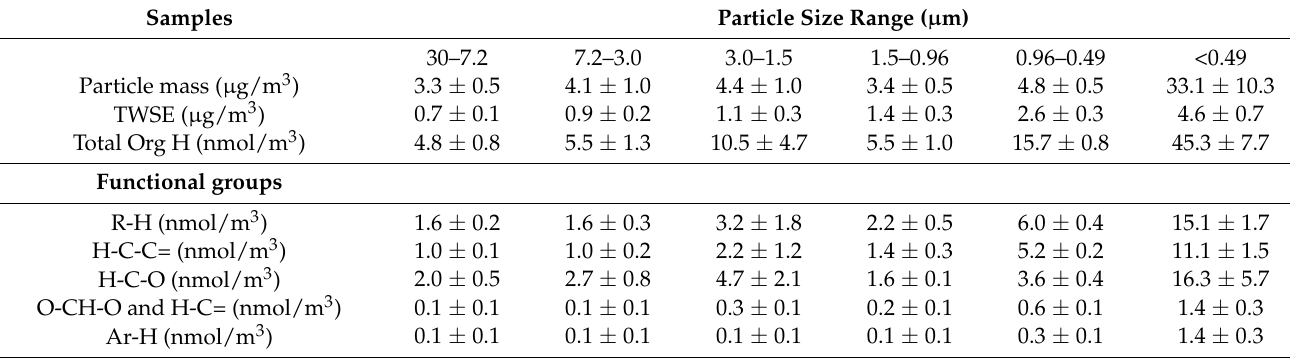
Table 1. Mean ( ± standard error) of particle mass ( µ g/m 3 ), total water-soluble extract (TWSE; µ g/m 3 ), and non-exchangeable organic hydrogen molar concentrations (nmol/m 3 ) (R-H: saturated aliphatic; H-C-C=: allylic hydrogen; H-C-O: α -hydrogen to hydroxyl, ether and ester; O-CH-O: acetal; H-C=: vinyl; Ar-H: aromatic) of size segregated urban aerosol.